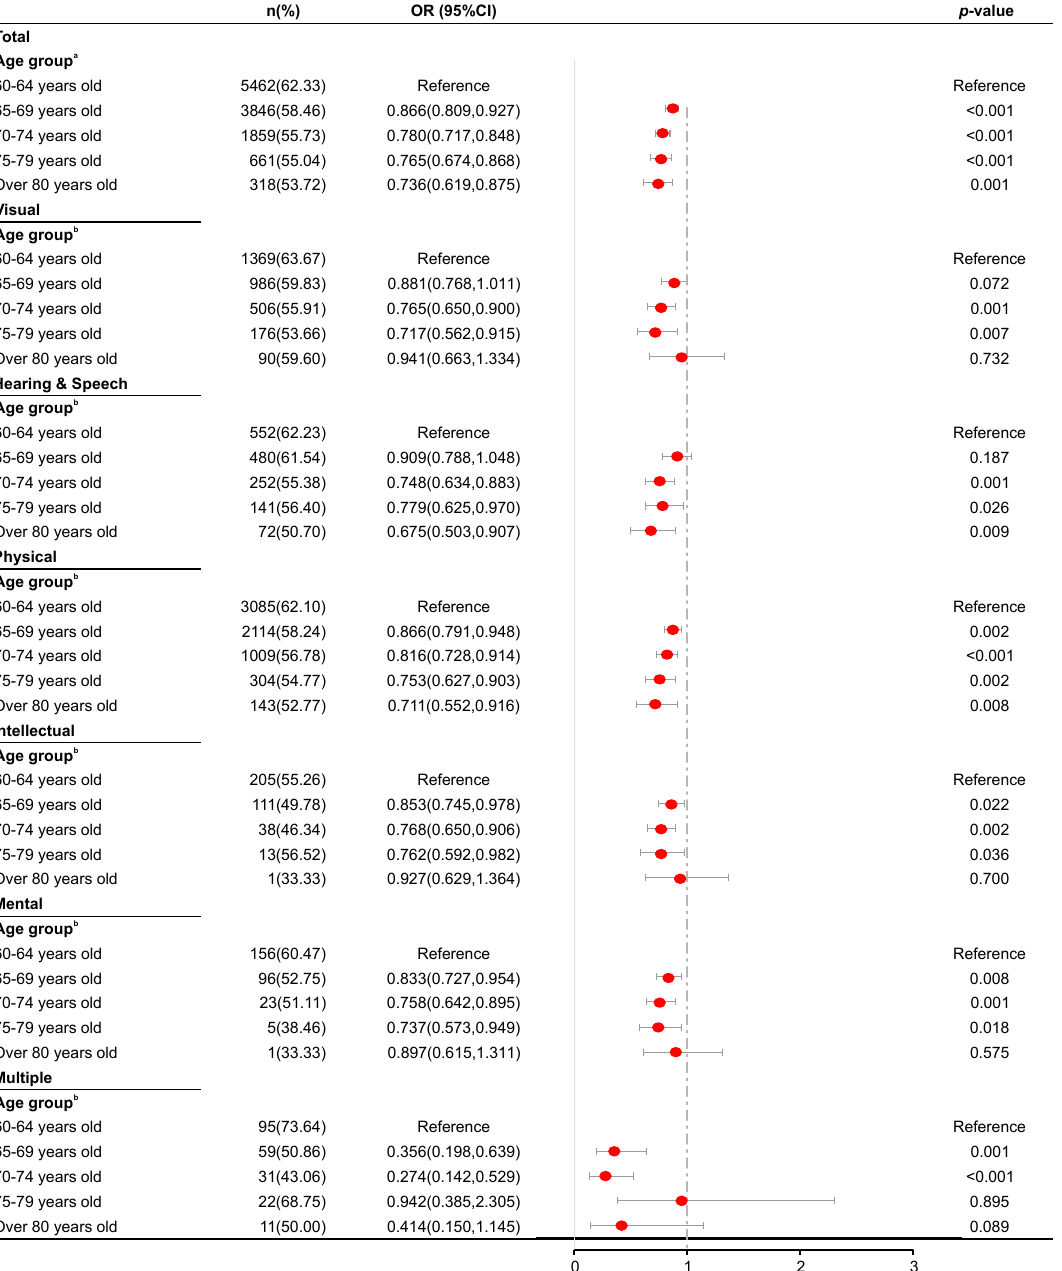
Figure 3. Results of a logistic regression analysis of hyperlipidemia according to age groups across disability types. a Adjusted for sex, residence permit, education level, marital status, disability type, and disability severity. b Adjusted for sex, residence permit, education level, marital status, and disability severity.